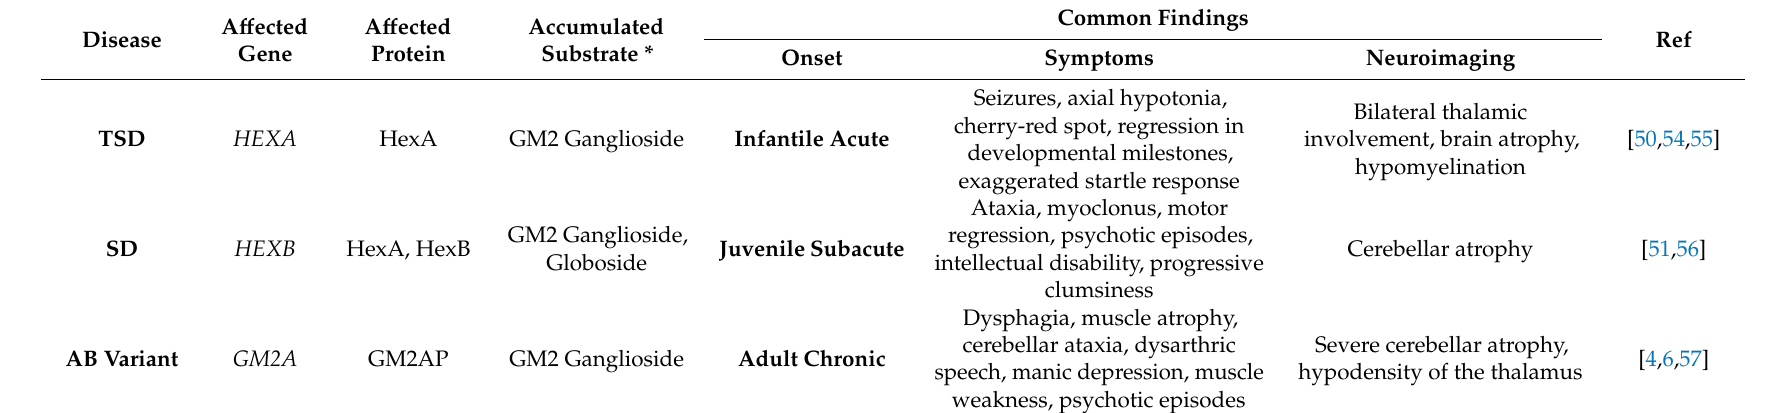
Table 1. Main neurological features in GM2